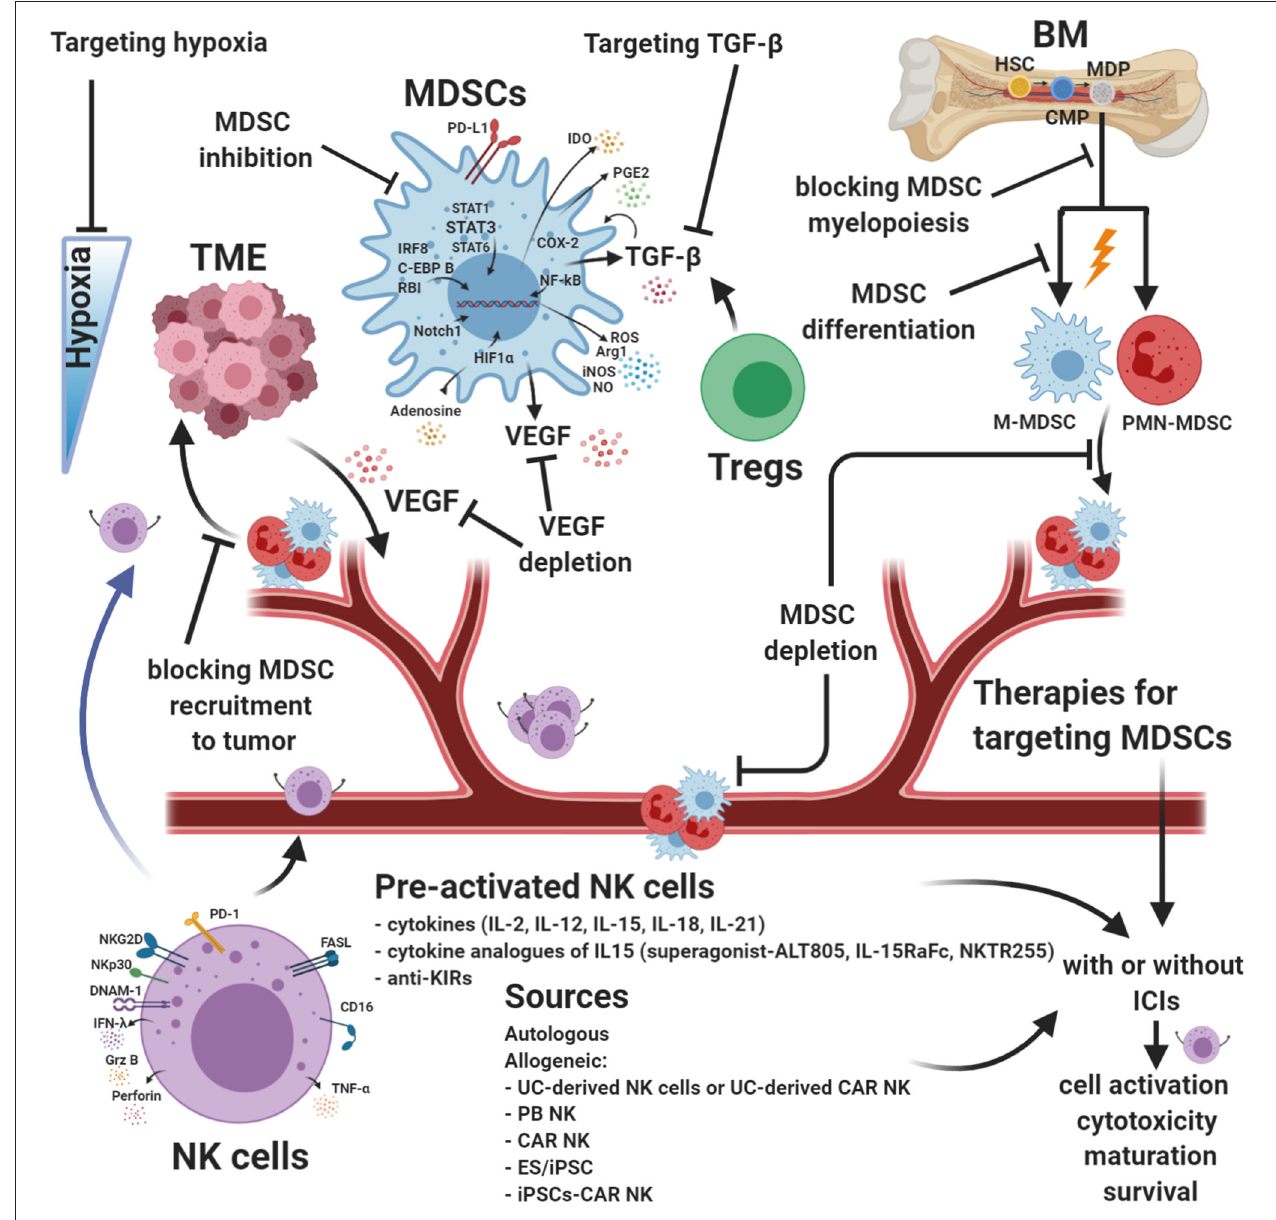
FIGURE 3 | Strategies for targeting MDSCs and augmenting NK cell functions. Myeloid-derived suppressor cells (MDSCs) are robust immunosuppressors in the tumor microenvironment (TME) and represent an obstacle for many cancer immune therapies. Targeting MDSCs is a different approach designed to limit their immunosuppression within the TME and reduce neo-angiogenesis. Many combinatorial therapies are focused on blocking intratumoral recruitment and expansion of MDSCs. Other approaches are dedicated to increasing MDSC differentiation or inhibiting their immunosuppression activity. Natural killer (NK) cell-based immunotherapy strategies have been studied in an increasing number of clinical trials. Although NK cells can be useful in some types of cancer, it is necessary to improve the efficacy of currently available NK cell products to avoid cell exhaustion. Innovative combinatorial approaches intended to improve NK cell function and block MDSCs are in development. MDSC targeting, enhanced NK cell cytotoxic activity, and drugs targeting hypoxia can be used with current cancer therapies, including immunotherapy, and may improve antitumor response efficacy. ICIs, immune checkpoint molecules. Created with